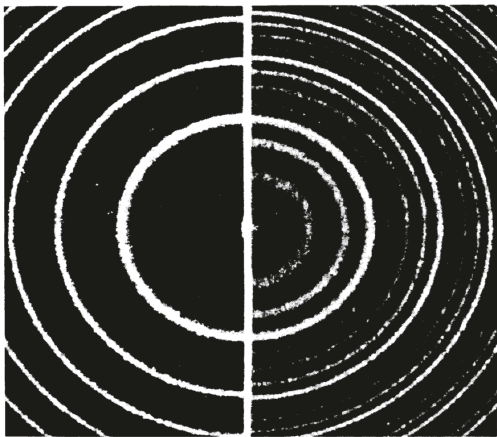
Figure 2: Fabry-Perot interferogram from Q-switched ruby laser (left) and from SBS in nitrobenzene (right). After the first order Stokes ring, additional rings are attributed to phase conjugation returningthe Stokes lighttothelaserwhereitexperiencesadditional gain in the inhomogeneously broadened ruby laser [adapted from